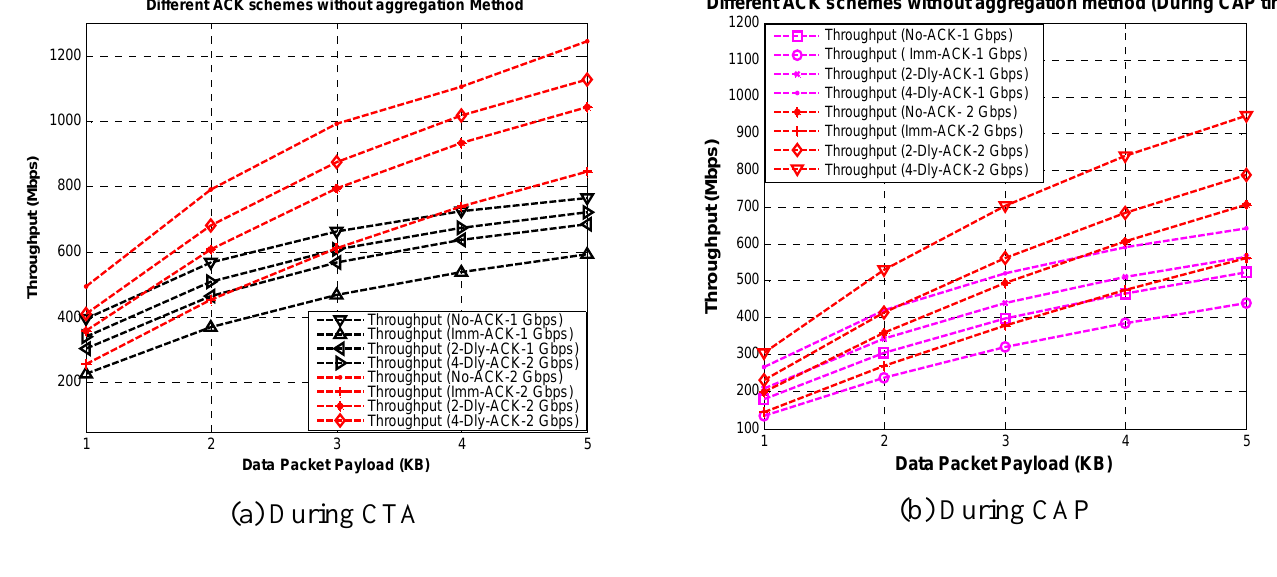
Figure 7. Throughput versus payload size with different ACK policies without aggregation during CTA and CAP.